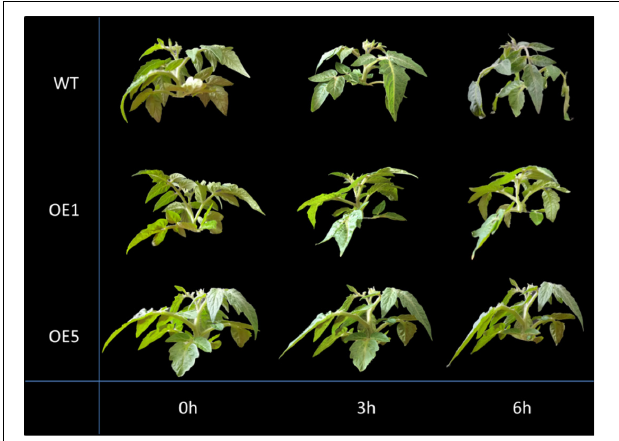
FIGURE 4 | Phenotype comparison of representative SlGATA17 transgenic tomato plants and WT plants under drought stress. in Figure 8 . Regulatory points A and F had the largest number of DEGs (10 and 6, respectively). There was only one gene at the D and I regulatory points. Most of the genes showed more than twofold change expression levels at two or three time points. After 3 h, the number of genes that had higher expression levels in the OE plants than in the WT plants increased, indicating